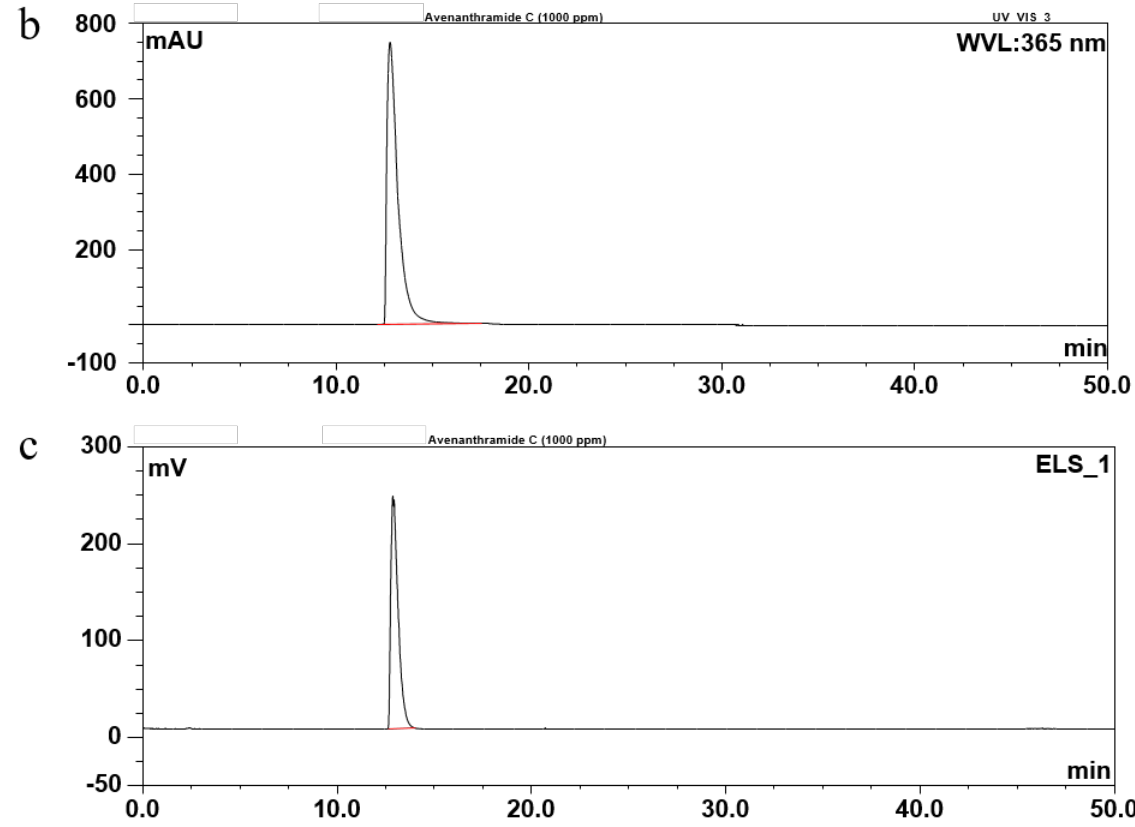
Figure 2. HPLC chromatograms of Avn-C isolated from Fr. 2. Avn-C was detected by UV 254 nm ( a ), UV 365 nm ( b ), and ELSD ( c ).